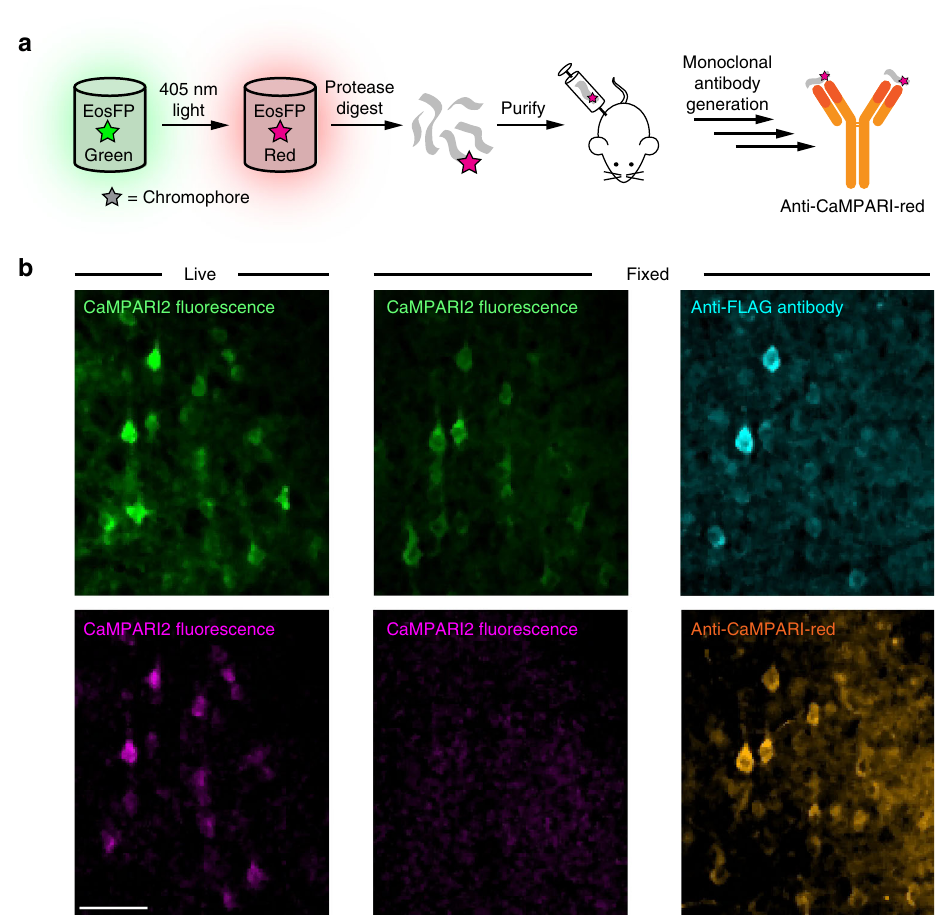
Fig. 5 Anti-CaMPARI-red antibody. a Schematic representation of the protocol used to generate the anti-CaMPARI-red monoclonal antibody. b Green (top) and red (bottom) endogenous CaMPARI2 fl uorescence (left and middle columns) in mouse brain tissue imaged before (left column) and after (middle column) chemical fi xation with paraformaldehyde. The right column shows the same region of fi xed tissue after antibody staining with anti-FLAG antibody for total CaMPARI (top, cyan) and anti-CaMPARI-red antibody (bottom, orange). Note that following chemical fi xation much of the red CaMPARI fl uorescence was lost but was recovered with the anti-CaMPARI-red antibody staining. Scale bar is 50 µ